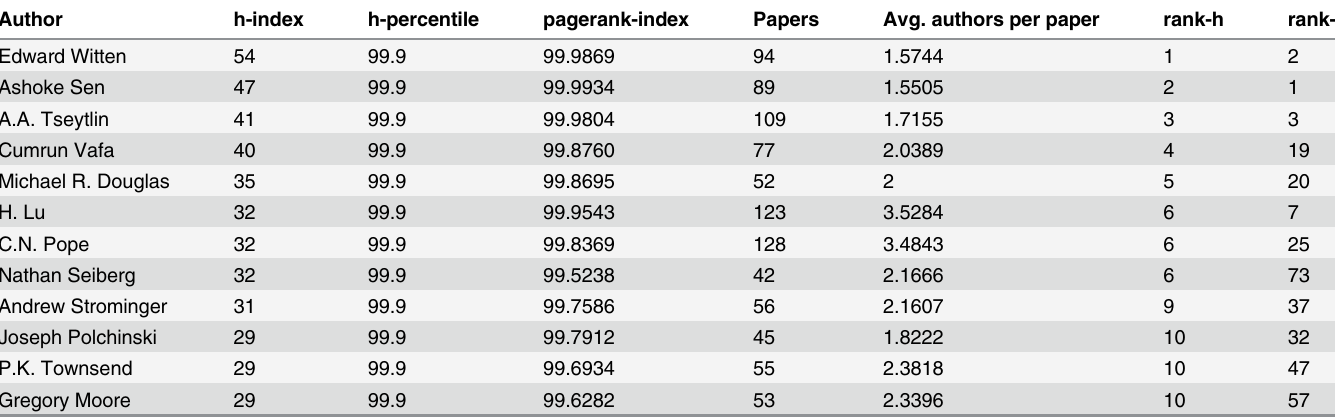
Table 3. The top 12 scientists as ordered by their h-index in the HEP-TH dataset.